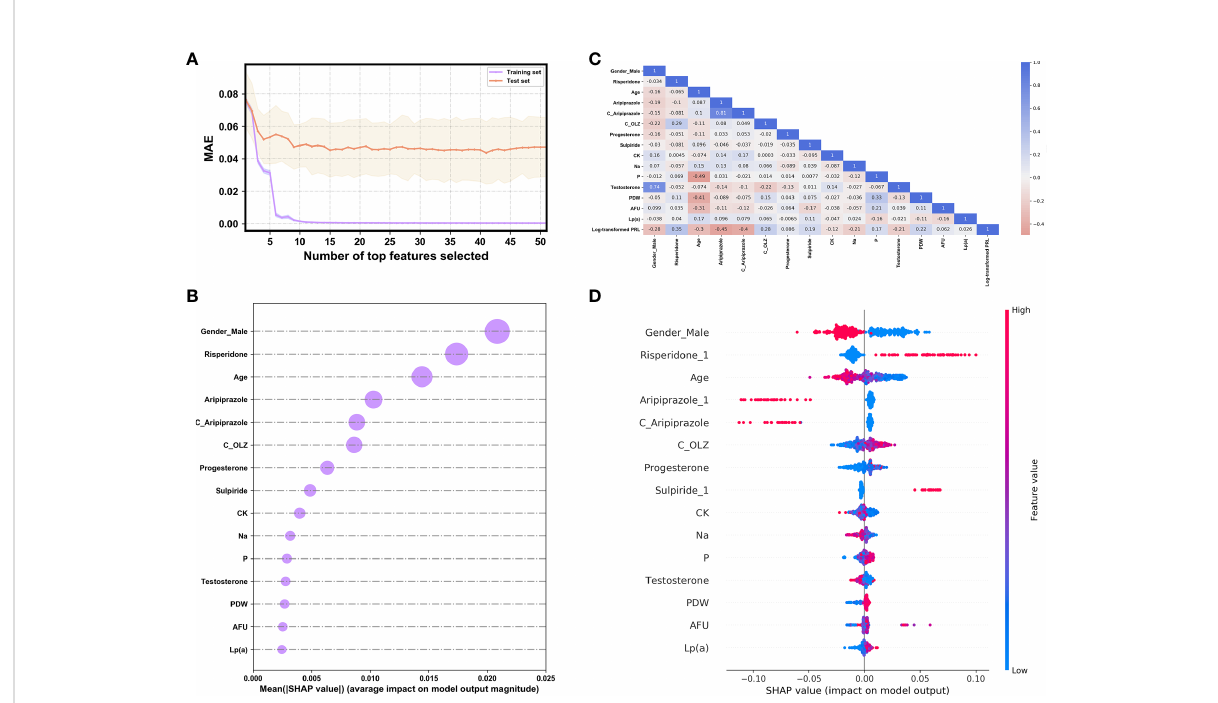
FIGURE 3 (A) The evolution of the performance of XGBoost models on the derivation cohort based on different compositions of the feature set. (B) The ranking by importance of the top 15 features according to the mean (|SHAP value|). (C) Heat map of the correlations between the log- transformed PRL and the selected features as analyzed by Pearson ’ s correlation coef fi cient. (D) The SHAP summary plot of the top 15 features. The red (blue) dots denote the high (low) values of the features. The high (low) SHAP values of the features denote their high (low) log- transformed PRL